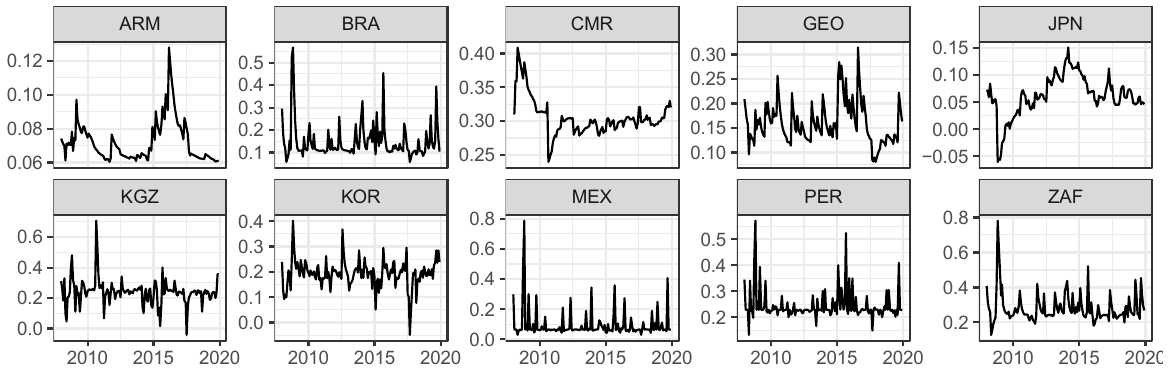
Figure 2. The movements in volatility transmissions. The panels show the movements in dynamic conditional correlations between global and local wheat prices calculated by the DCC-GARCH model. Overall, the movements in dynamic conditional correlations show strong time vari- ability in the sample period and considerable country dependence. For almost the entire sample period, dynamic conditional correlations are positive for sample countries,